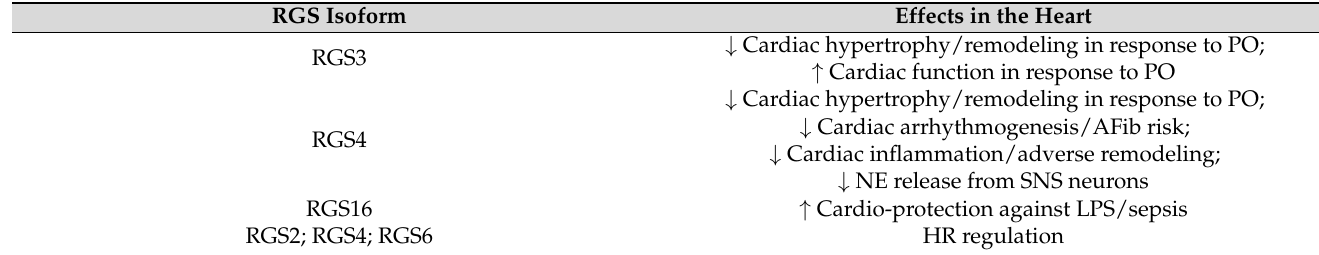
Table 1. Summary of the most important documented effects of cardiac RGS